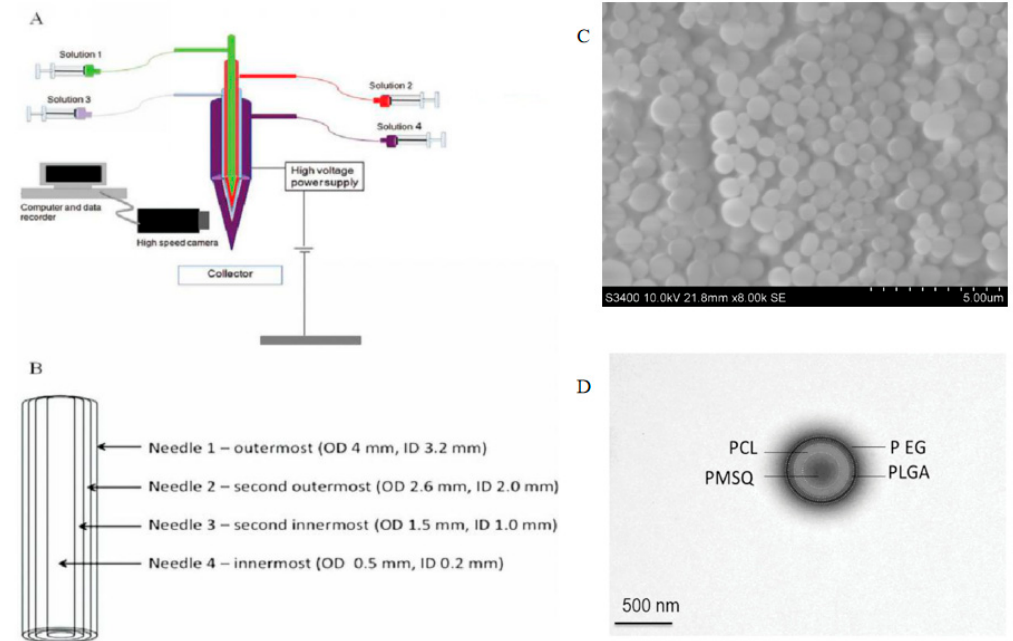
Figure 5. Schematic illustration of ( A ) the experimental set-up of the EHD process using a four-needle device for forming four-layer structures with a stable jet (inset); ( B ) the coaxial needle arrangement with labeled dimensions, where ID and OD are internal and outer diameters, respectively; ( C ) SEM image of four-layered particles at low magnification; ( D ) bright-field TEM image of a particle showing four distinct layers (Adapted from [64]).